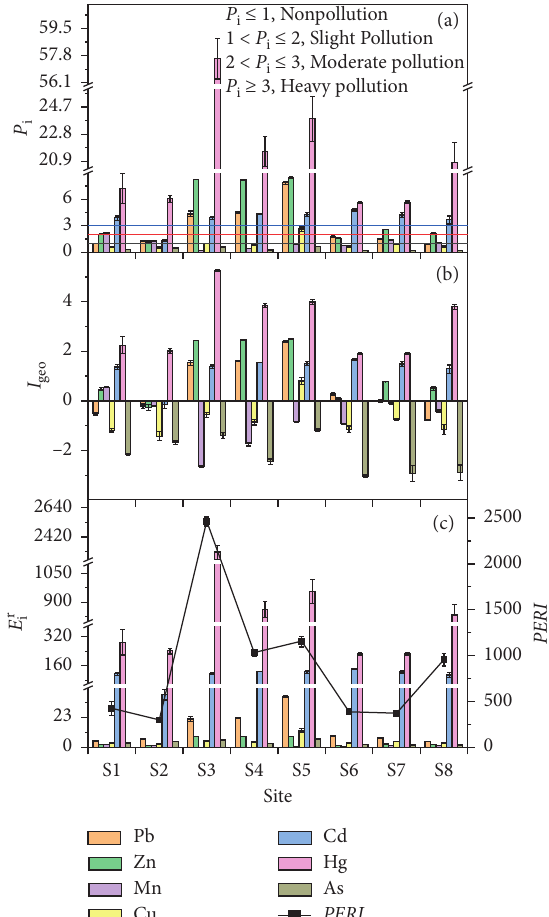
Figure 3: Evaluation results with P i (a), I geo (b), and PERI (c) for the pollution status of HMs in sediments around this lead-zinc